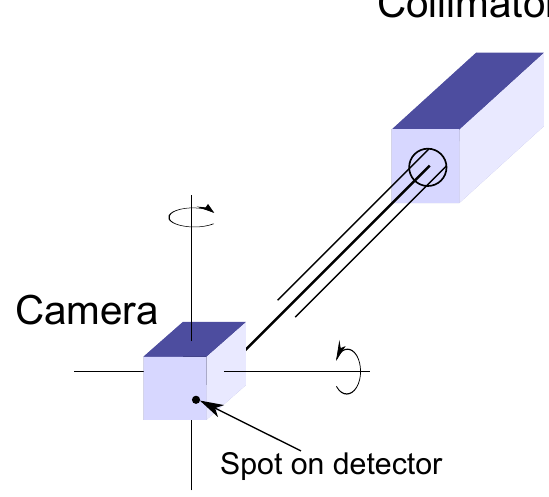
Figure 2: Schematic of the goniometric calibration